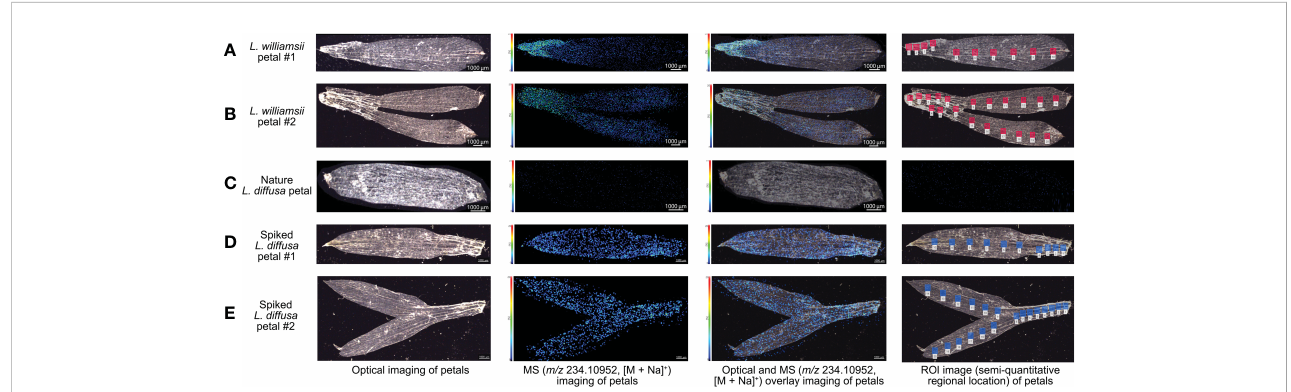
FIGURE 4 Optical imagings, MS imagings with a resolution of 30 µm ( m/z 234.10952, [M + Na] + ), optical and MS overlay imagings and ROI semi-quantitative regional location of mescaline analysed by MALDI-MSI in positive ion mode in different petal samples. (A) Petal sample 1 of Lophophora williamsii . (B) Petals sample 2 of Lophophora williamsii . (C) Petal sample of Lophophora diffusa . (D) Spiked petal sample 1 of Lophophora diffusa . (E) Spiked petals sample 2 of Lophophora diffusa